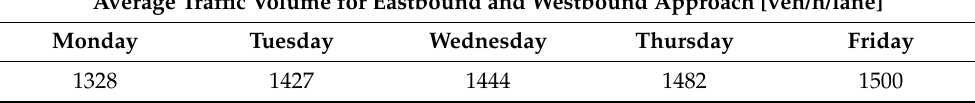
Table A3. Average vehicular delay from 9 a.m. to 10 a.m. for weekdays. Average Delay [s/veh] Mon